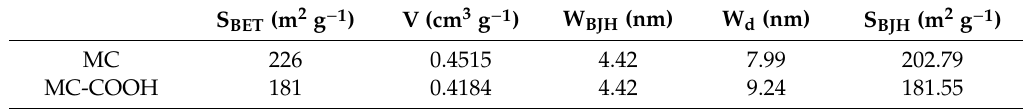
Table 1. Pore structure parameters of MC and MC-COOH.